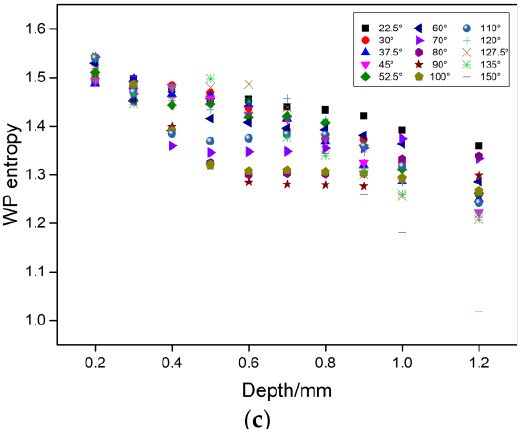
Figure 12. ( a ) Scatter plot of WP coefficient peaks; ( b ) scatter plot of WP energy peaks; ( c ) scatter plot of WP entropy.